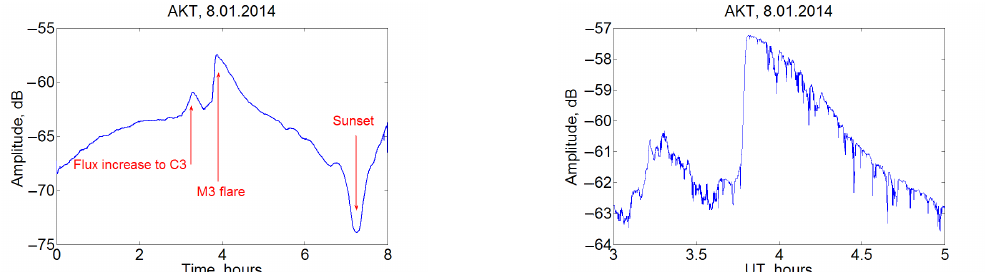
Figure 3. Example of SID events in the signals received by the AKT station during the solar flare on 8 January 2014: VLF amplitude in 0–8 UT with 10-min moving average ( left ) and the signal without processing in 3–5 UT ( right ) . Moments of C3 and M3 solar flares are shown by the upward red arrows, and sunset is indicated by the downward red